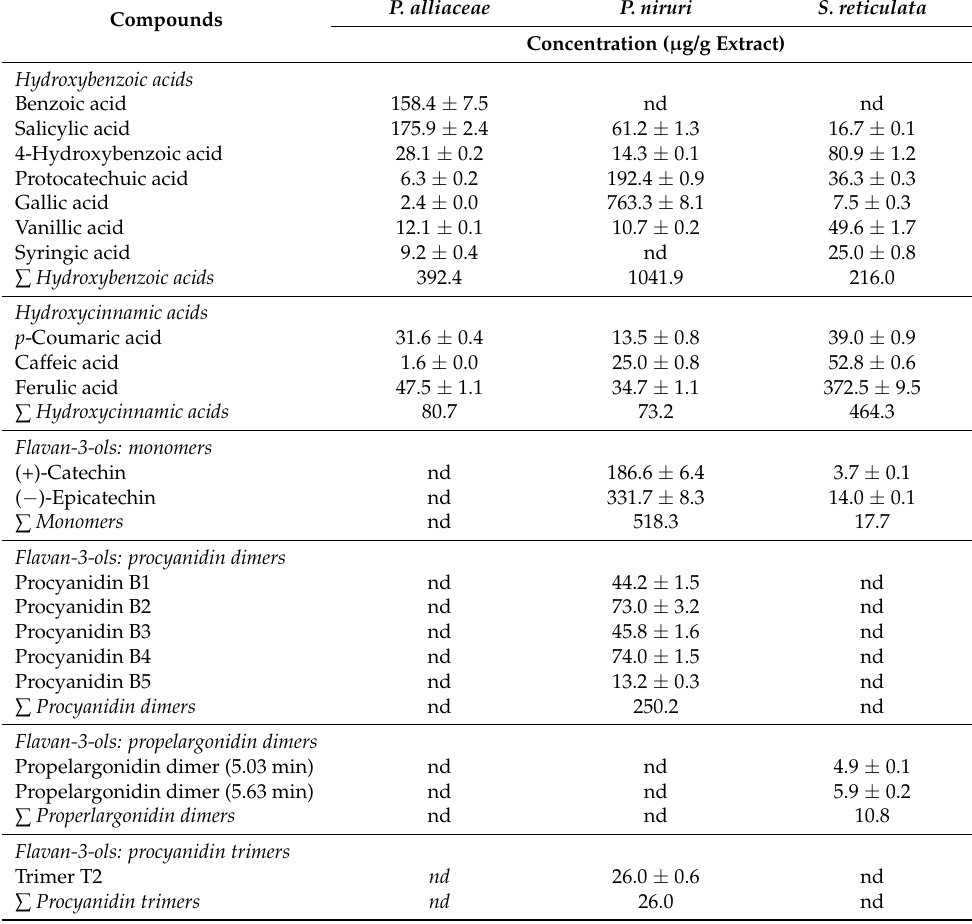
Table 2. Phenolic composition of P. alliaceae , P. niruri and S. reticulata extracts.